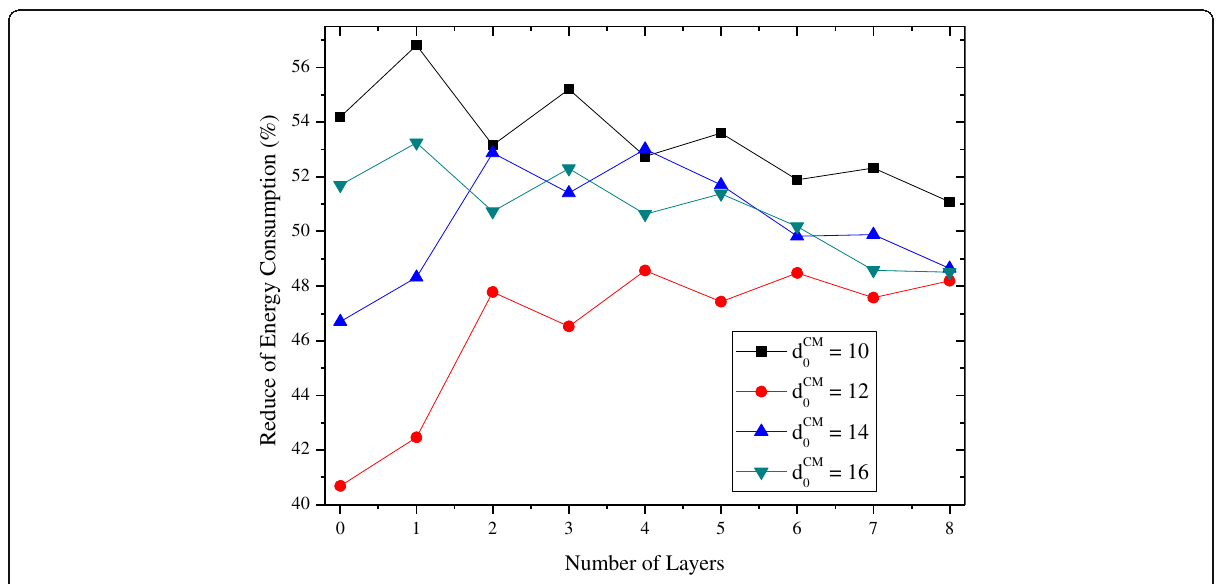
Fig. 17 The reduced percentage of the energy consumption (different d CM